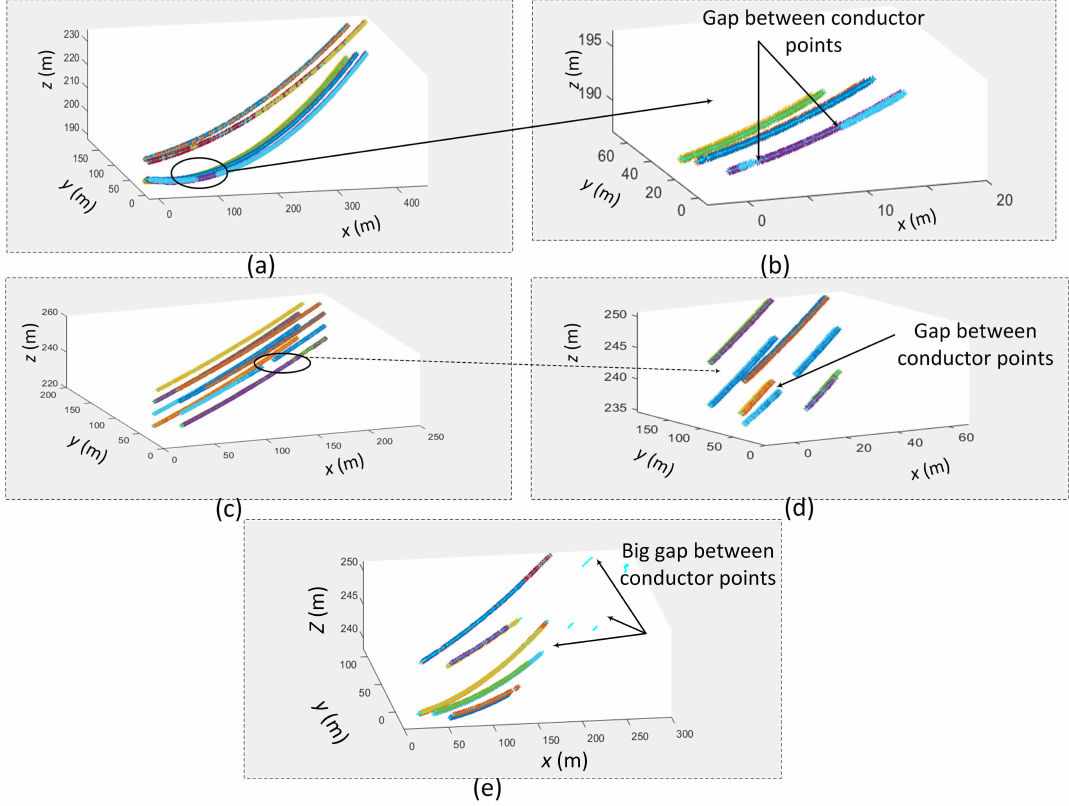
Figure 15. Robustness to breakage. In panel ( a ) the origin (0, 0) represents (5.151 × 10 5 , 6.9219 × 10 6 ), in panel ( b ) the origin (0, 0) represents (5.152 × 10 5 , 6.9219 × 10 6 ), in panel ( c ) the origin (0,0) represents (5.1545 × 10 5 , 6.92178 × 10 6 ), in panel ( d ) the origin (0,0) represents (5.1547 × 10 5 , 6.92178 × 10 6 ) and in panel ( e ) the origin (0, 0) represents (5.156 × 10 5 , 6.92164 × 10 6